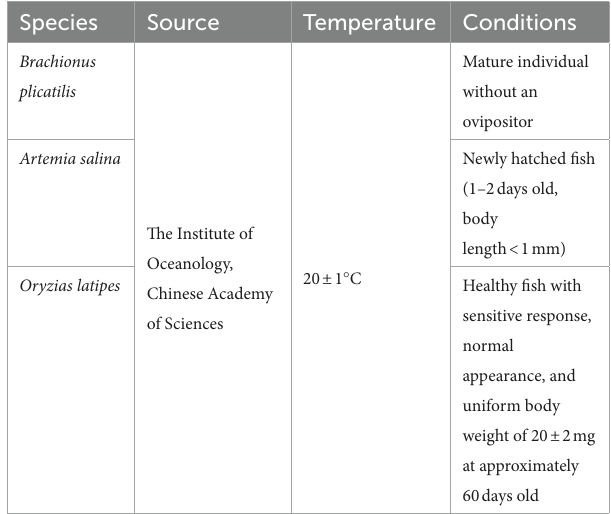
TABLE 1 The source and cultivation conditions of the test